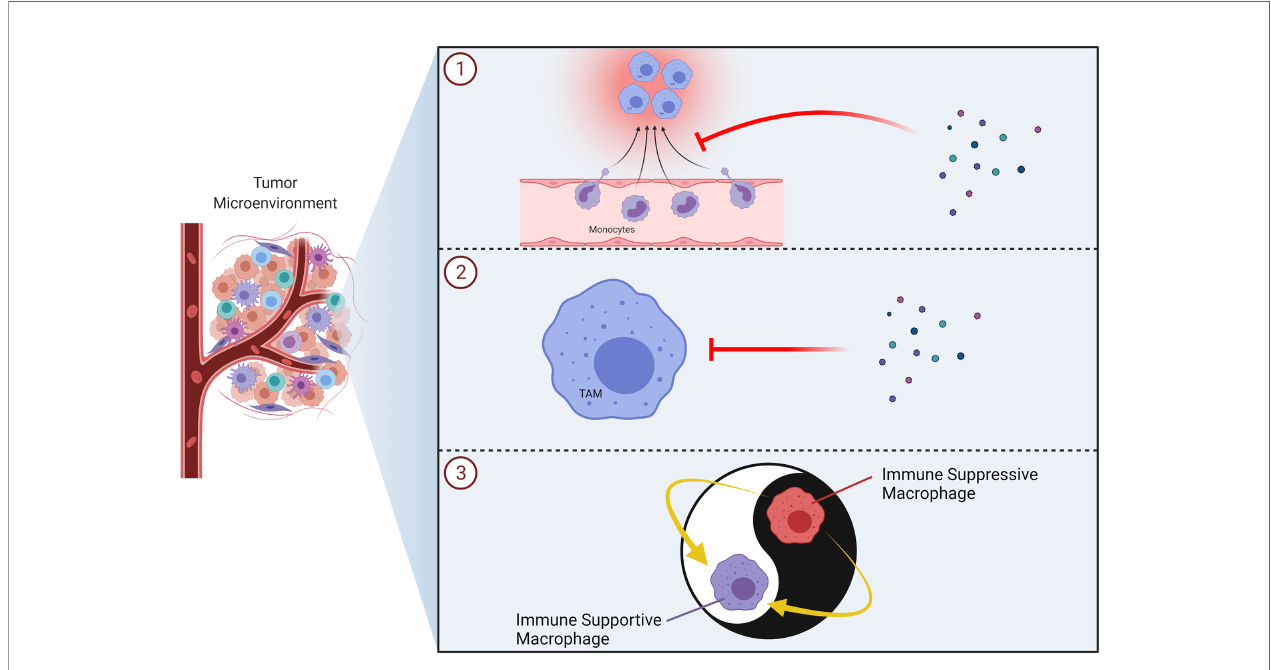
FIGURE 9 | Therapeutic Strategies to Target TAMs in Tumors. Schematic illustrations of the TAM-targeting approaches including inhibition of monocyte/ macrophage recruitment ( e.g. CXCR4, CCR2 inhibitors) ① , inhibition/elimination of macrophages in the tumor microenvironment ( e.g. bisphosphonates) ② and reprogramming of TAMs into immune supportive macrophages ( e.g. TLR7/8 agonist) ③ are demonstrated. TAM, tumor associated macrophage; TLR, toll-like